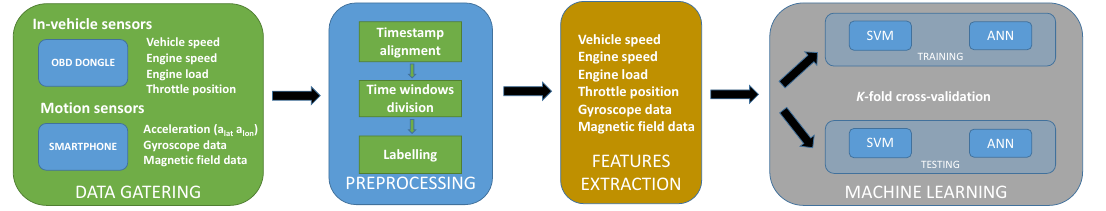
Figure 1. Algorithmic workflow of the proposed